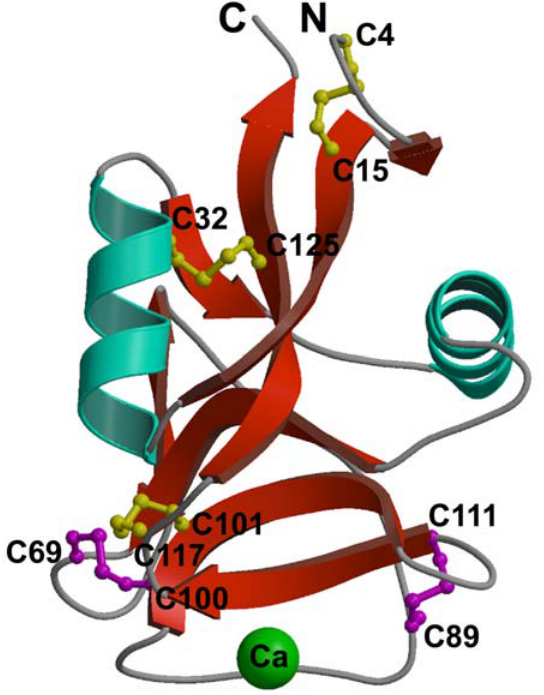
Figure 1. Ribbon representation of the hAFP structure. The positions of ten cysteine residues are labeled. Three conserved disulfide bonds (Cys4-Cys15, Cys32-Cys125, and Cys101-Cys117) are shown in yellow and two unique disulfides bonds (Cys69-Cys100 and Cys89-Cys111) in magenta. The Ca 2 + ion is shown in green. This diagram was generated using the programs MOLSCRIPT and Raster3D [39,40].